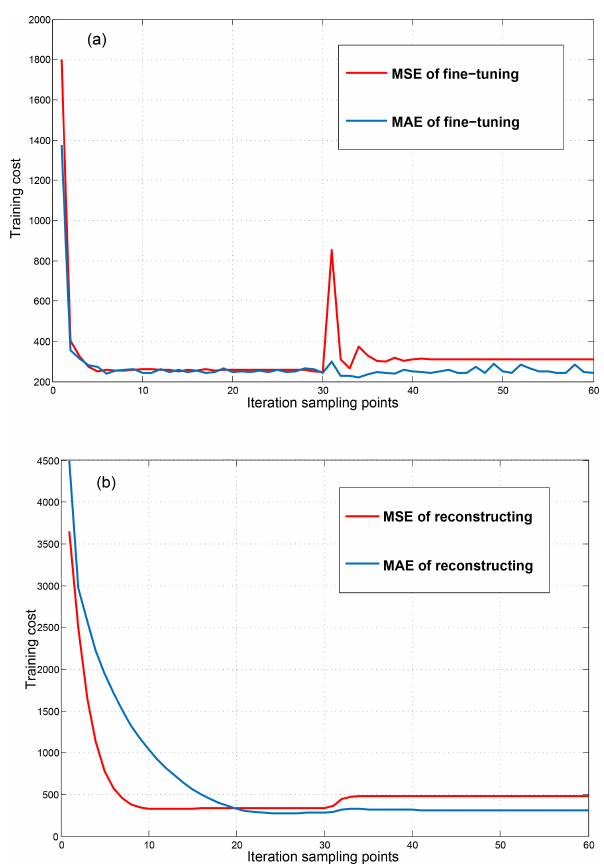
Figure 4. The training cost comparison of MAE and MSE (mean squared error): (a) is the training cost of fine-tuning, and (b) is the training cost of